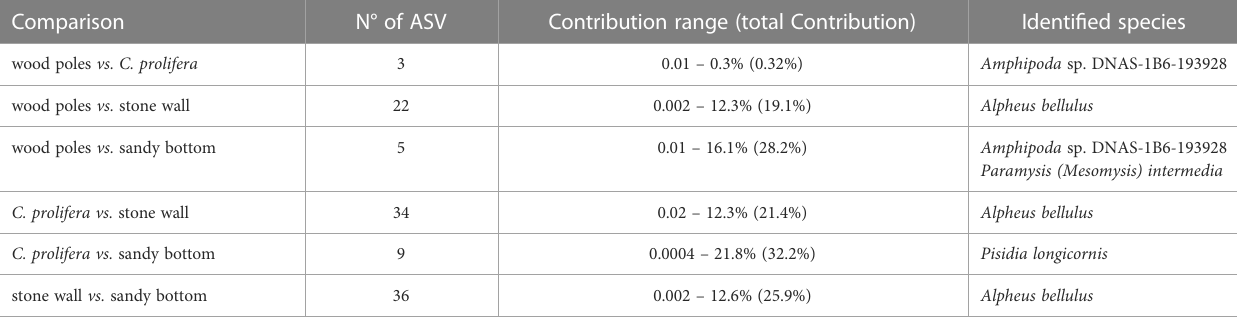
TABLE 2 Results of SIMPER analysis: the number of ASVs signi fi cantly (p-values ≤ 0.05) contributing to between group diversity, contribution (portion of the diversity) range and identi fi ed species. Comparison